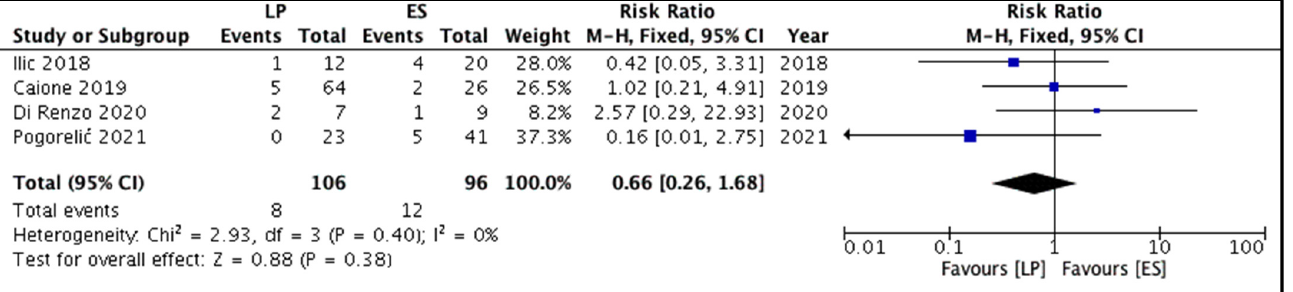
Figure 3. Forest plot comparison between the two patient groups in terms of the requirement of endoscopic retreatment for ureterocele decompression. Legends: LP, laser puncture patient group. ES, electrosurgical incision patient group. M-H, Mantel-Haenszel method. CI, confidence interval.